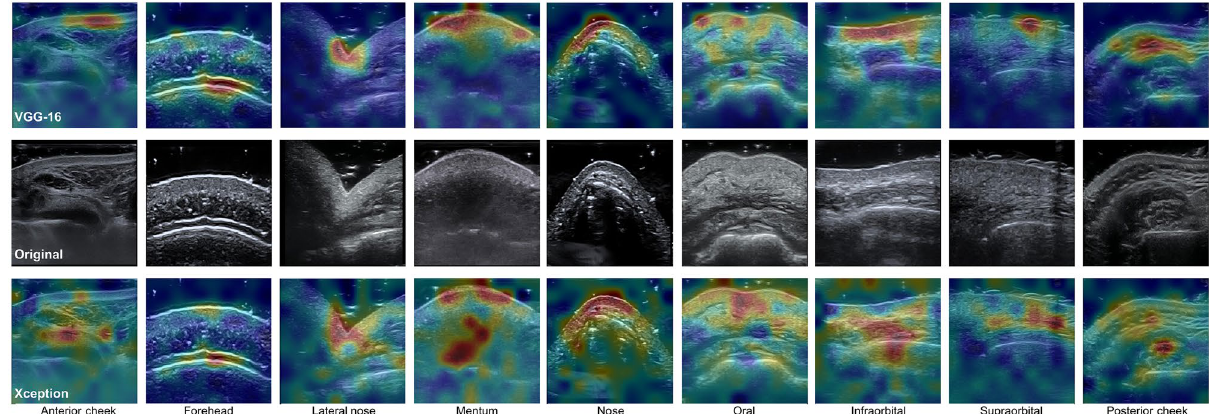
Figure 7. LIME analysis of classification criteria for the facial region of VGG-16 and Xception. The top row is the local features considered by VGG-16, the middle row is the original image, and the bottom row is the local features considered by Xception. The red area is the strongly weighted local, and the blue area is the weakly weighted